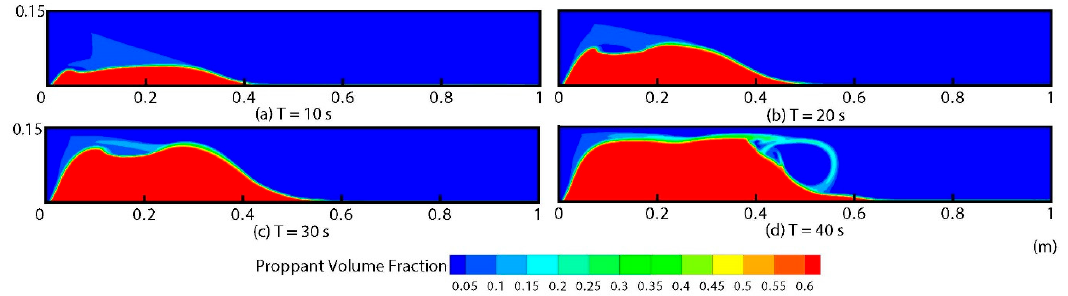
Figure 2. The distribution of the proppant in the primary fracture at time ( a ) 10 s, ( b ) 20 s, ( c ) 30 s, and ( d ) 40s. (Case 3 in Table A1).